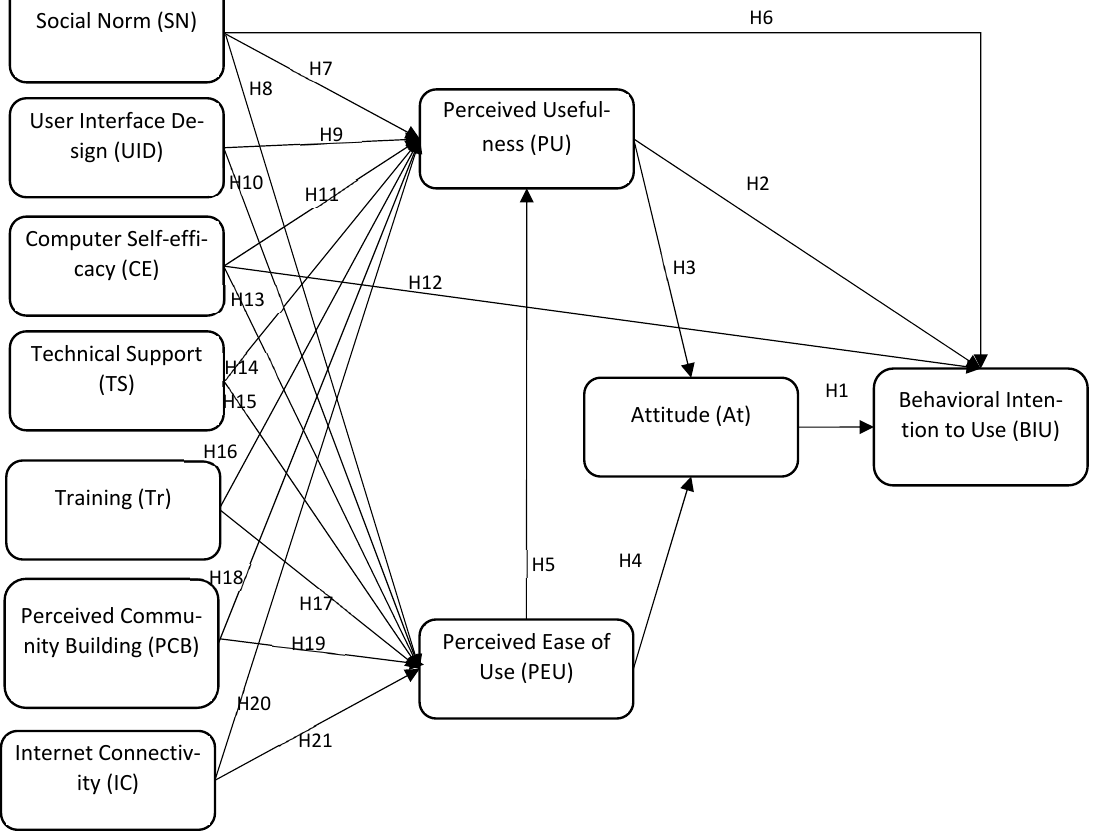
Fig. 2. Expected relationships between variables (proposed